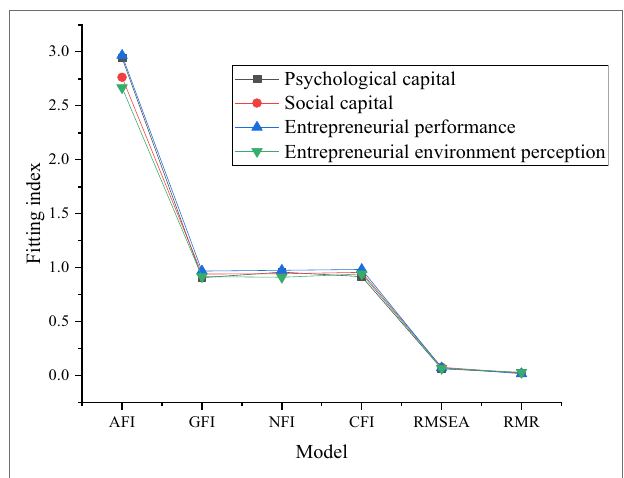
FIGURE 8 | Validity analysis results of the scale (AFI is the absolute fitting index; GFI, NFI, CFI, RMSEA, and RMR are the goodness-of-fit evaluation indexes of AMOS software).